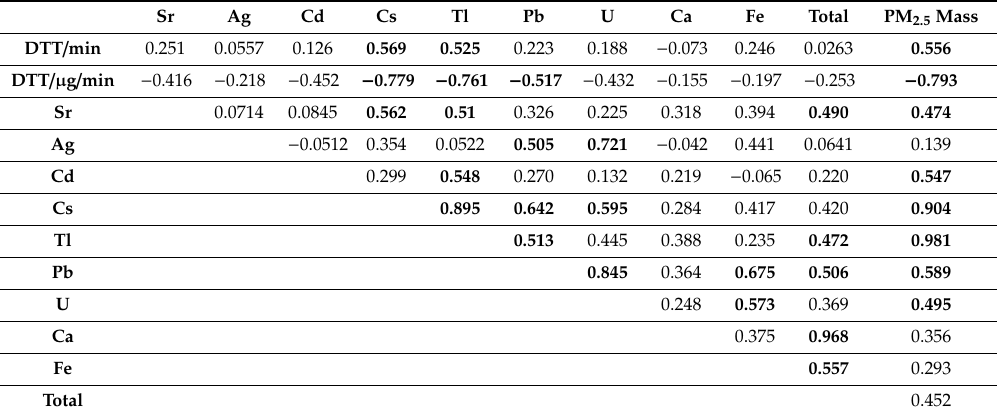
Table 1. Pearson’s Correlations for DTT, elements in ng, and PM 2.5 .